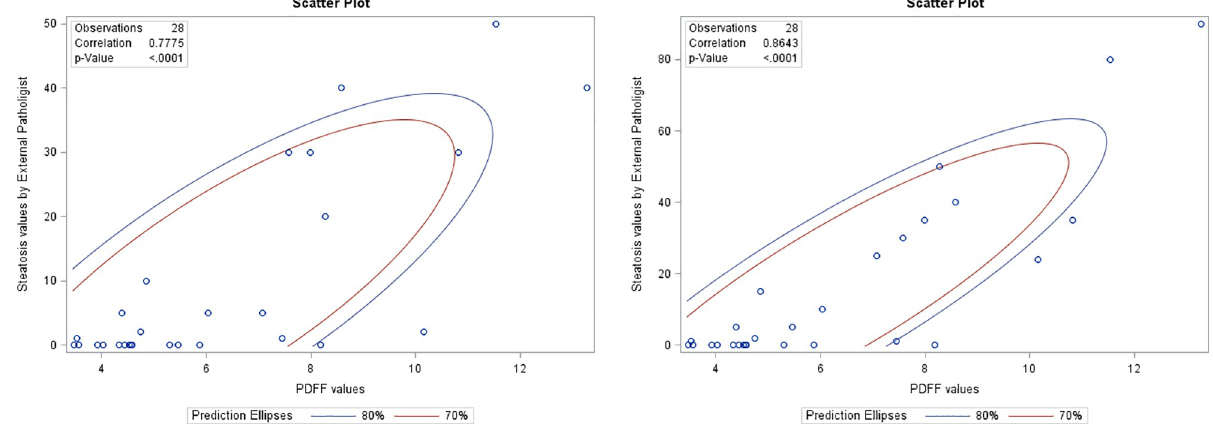
Fig 2. A. Correlation of MRI-PDFF with histology (external pathologist read out) when only macro steatosis was included. B. Correlation of MRI-PDFF with histology (external pathologist-read out) when macro plus micro steatosis was included.